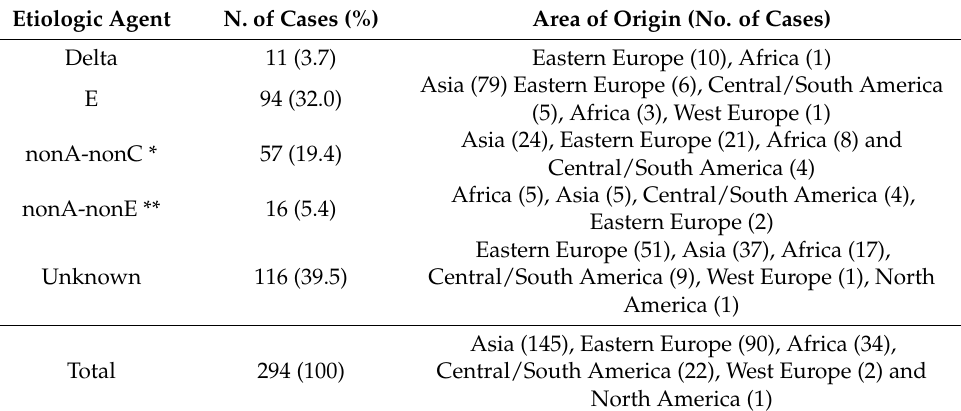
Table 3. NonA-nonC or unknown hepatitis: distribution by aetiology and geographic area of country of citizenship. SEIEVA 2004–2019. Etiologic Agent N. of Cases (%) Area of Origin (No. of Cases) Delta 11 (3.7) Eastern Europe (10), Africa (1) Asia (79) Eastern Europe (6), Central/South America E 94 (32.0) (5), Africa (3), West Europe (1) Asia (24), Eastern Europe (21), Africa (8) and nonA-nonC * 57 (19.4) Central/South America (4) Africa (5), Asia (5), Central/South America (4), nonA-nonE ** 16 (5.4) Eastern Europe (2) Eastern Europe (51), Asia (37), Africa (17), Unknown 116 (39.5) Central/South America (9), West Europe (1), North America (1) Asia (145), Eastern Europe (90), Africa (34), Total 294 (100) Central/South America (22), West Europe (2) and North America